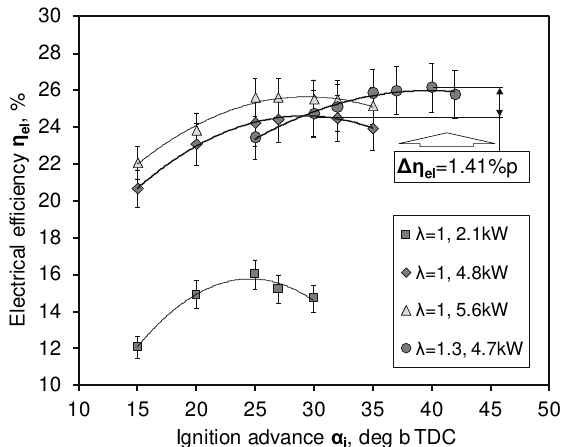
Fig. 3. Electrical efficiency vs ignition timing, throttle position and mix- ture composition